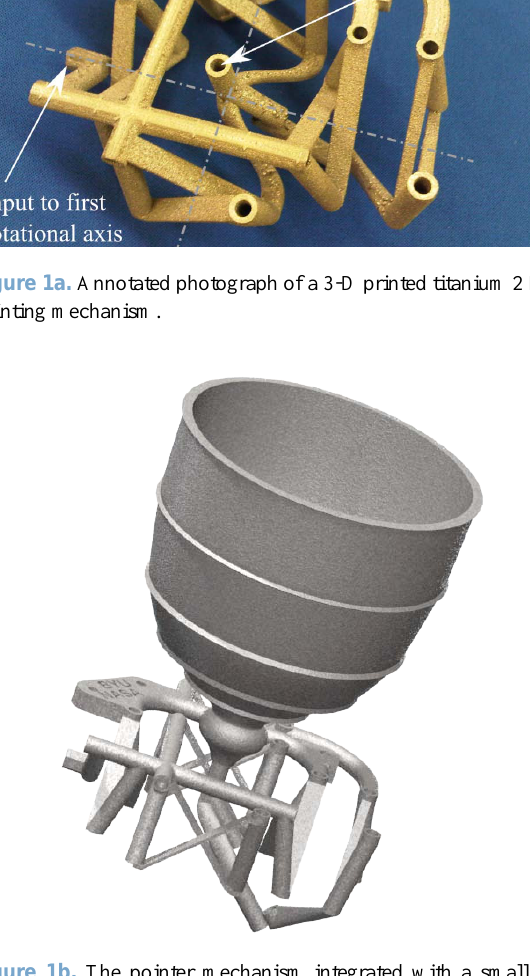
Figure 1b. The pointer mechanism integrated with a small atti- tude control thruster demonstrating compliant mechanism design in a space-centered application.